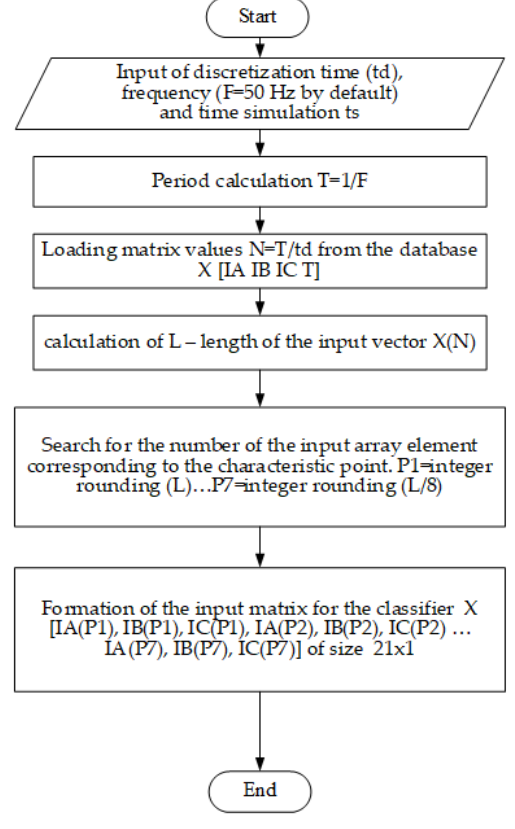
Figure 2. Data preprocessing algorithm.